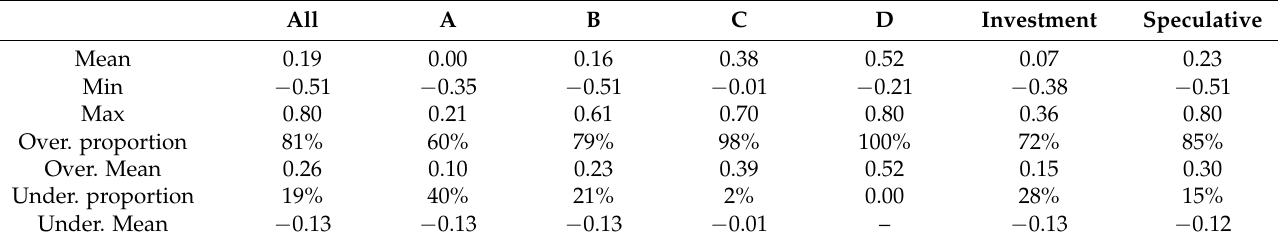
Table 4. Statistical results of the bias of